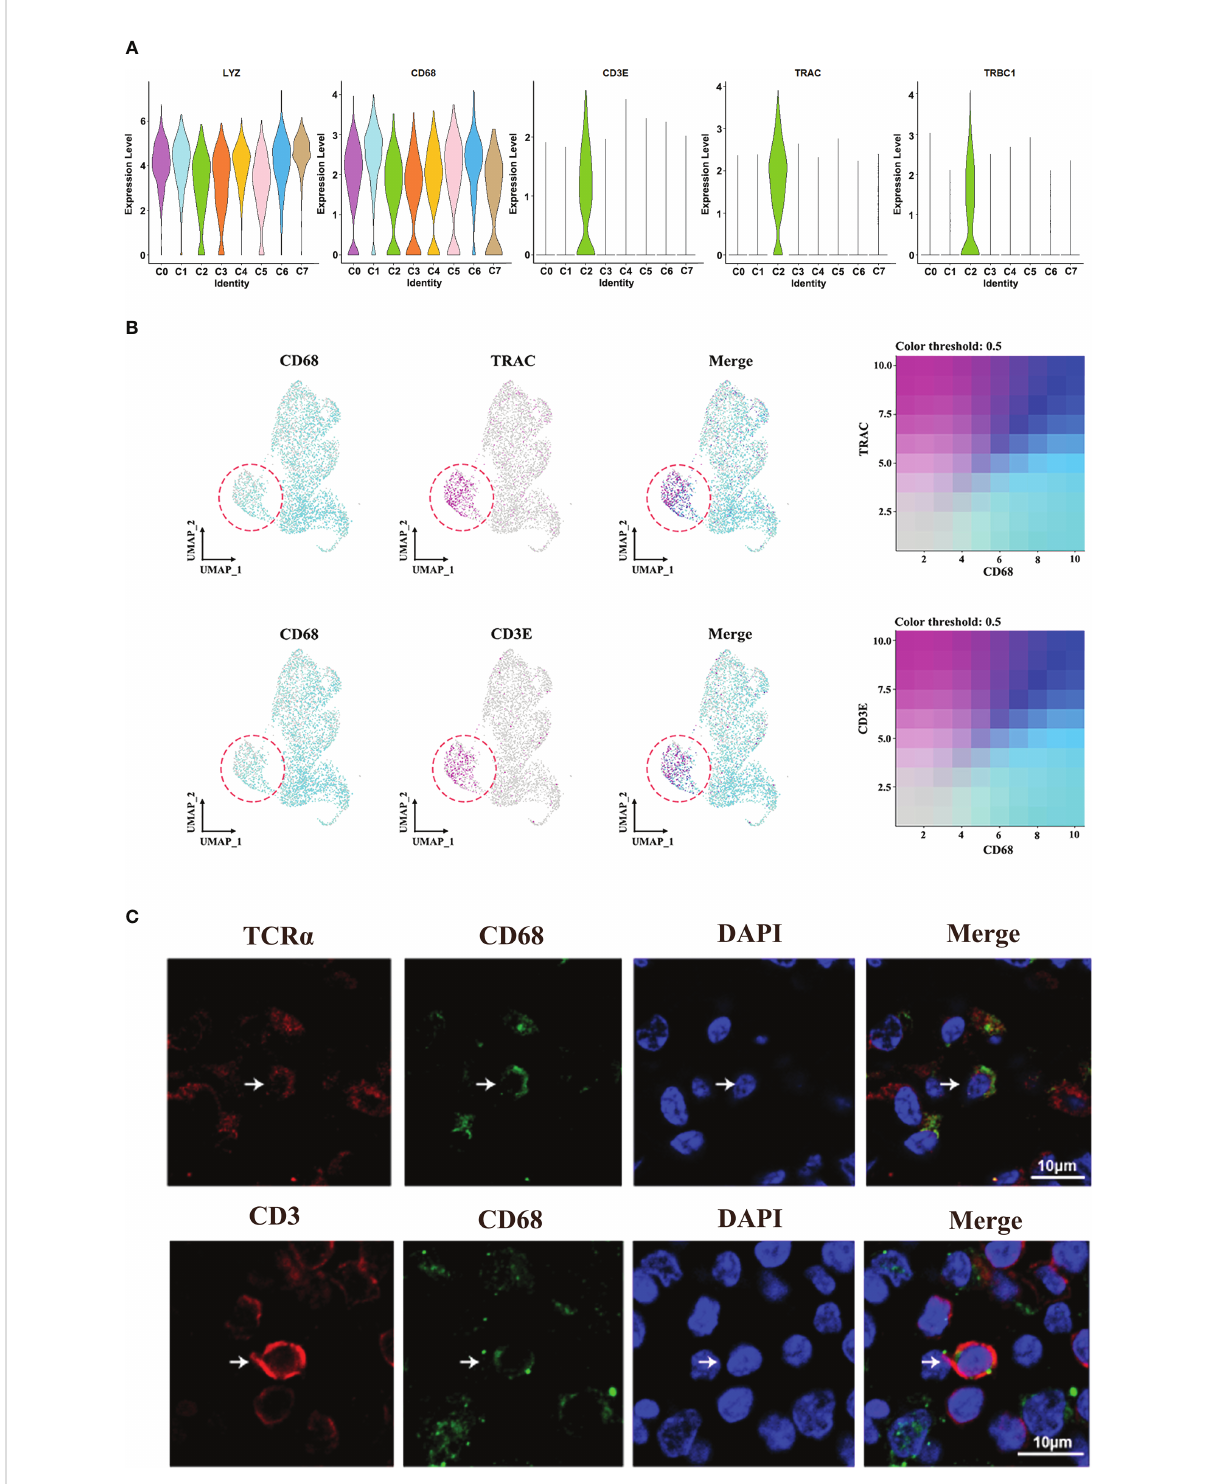
FIGURE 4 Identi fi cation of TCR + macrophages. (A) Violin plot of the speci fi c marker genes in cluster 2. (B) UMAP plot of cells with gene co-expression cells in cluster 2. (C) Representative immuno fl uorescence diagram of CD3 + CD68 + macrophage and TCR + CD68 + macrophage in